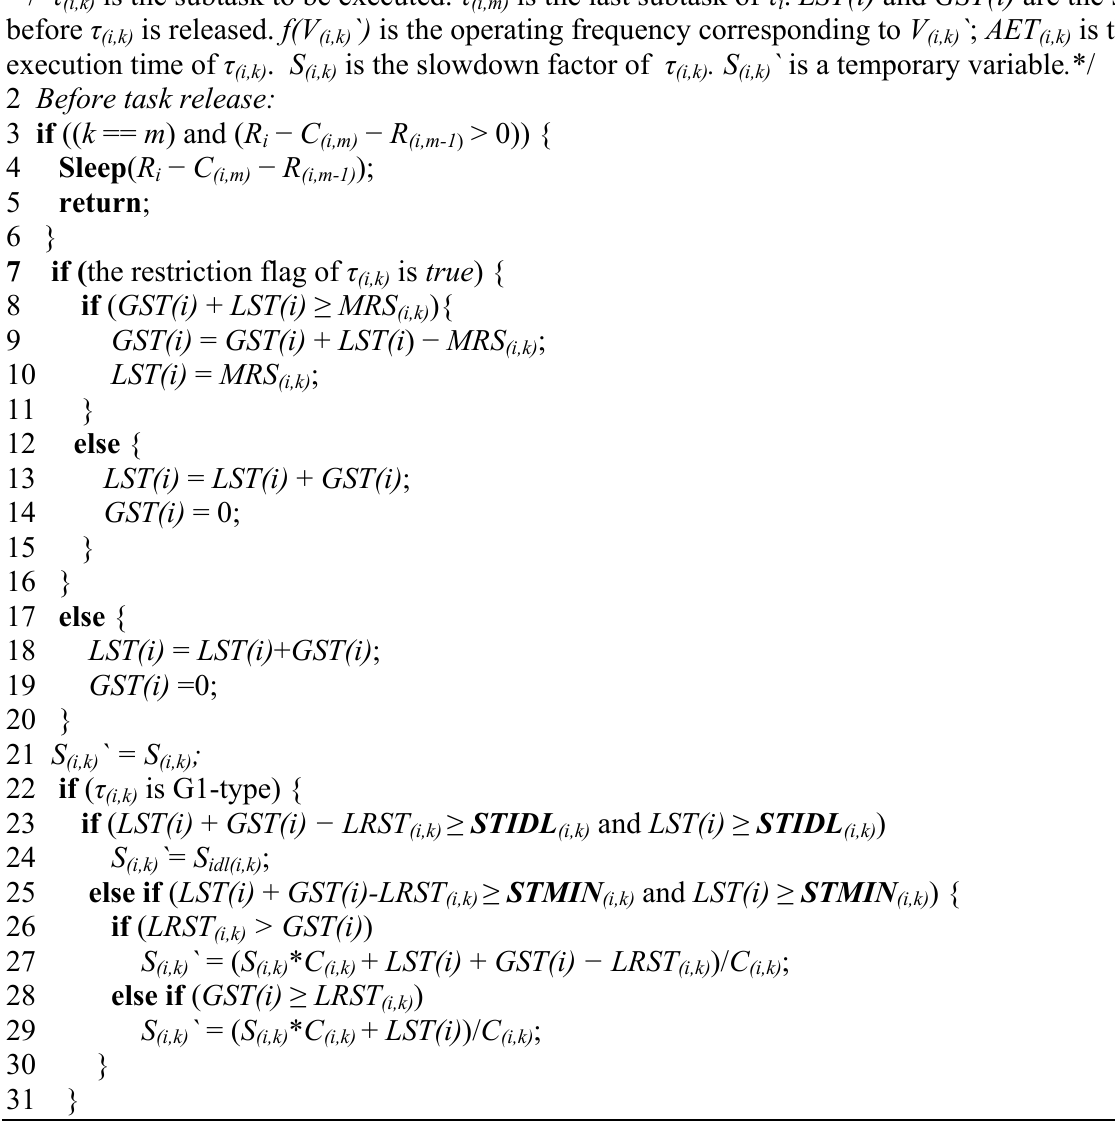
Algorithm 1. HTDVS-HRCT algorithm.